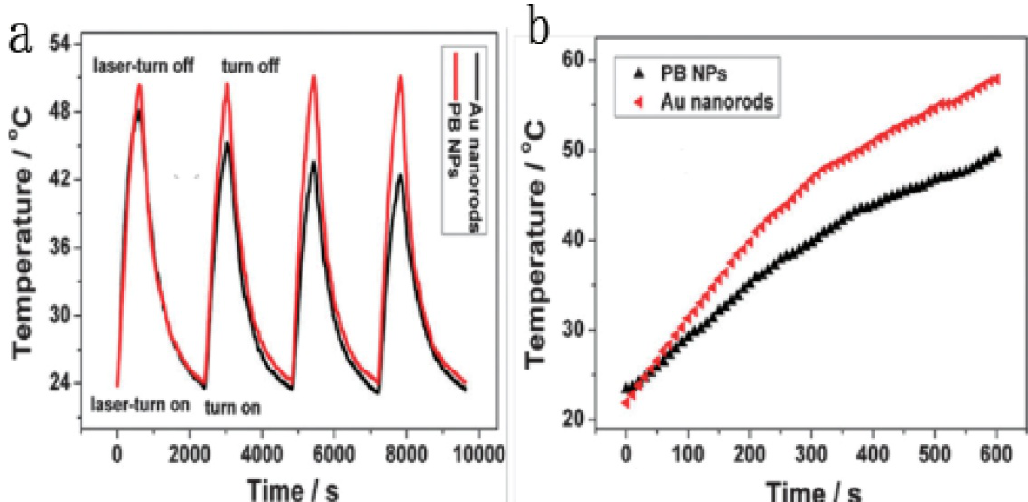
Fig. 6. (a) Temperature variations of PB NPs (50 ppm) and CTAB-capped Au nanorods (16 ppm) under the continuous irradiation of 808 nm laser for 4 cycles; (b) temperatures of aqueous dispersions of PB NPs and CTAB-capped Au nanorods with the same concentration (50 ppm) under the irradiation of 808 nm laser for 10 min. Reprinted with permission from G. Fu, W. Liu, S. Feng, X. Yue // Chemical Communications 48 (2012) 11567. Copyright 2012 Royal Society of